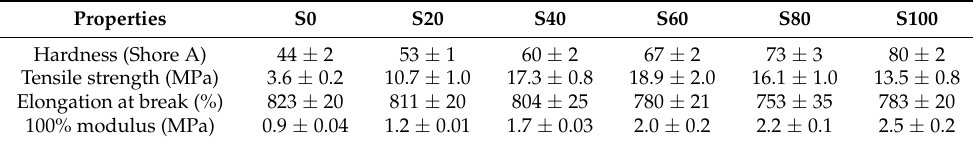
Table 3. Physical and mechanical properties of the EPDM/silica vulcanizates.